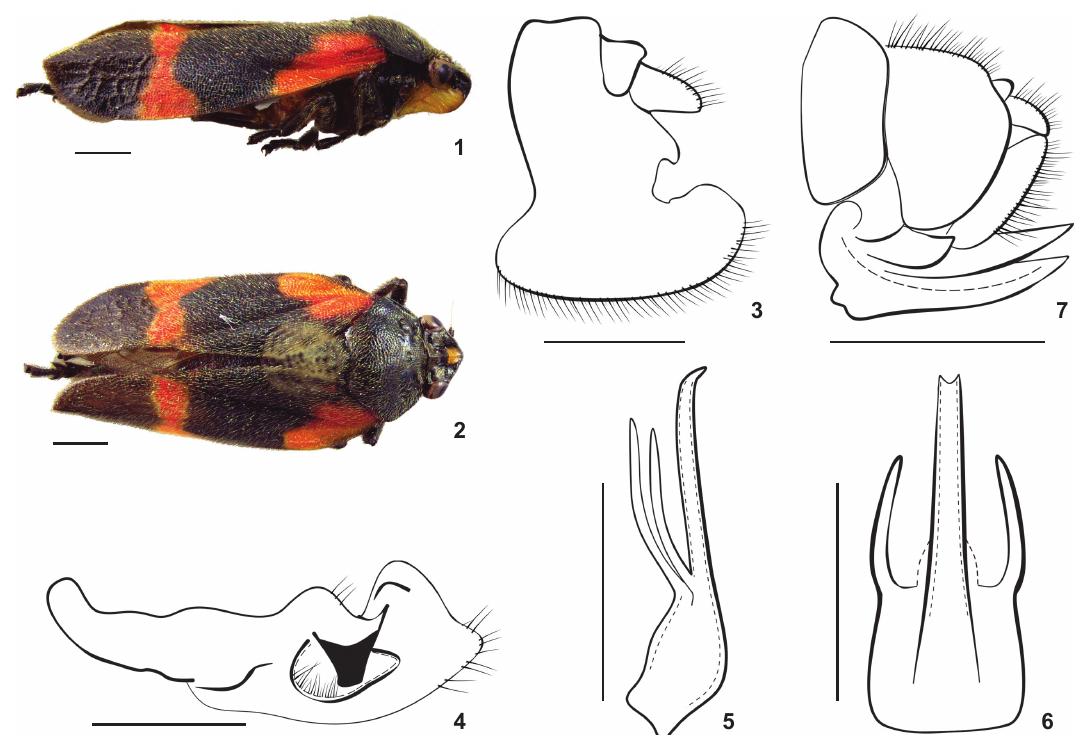
supra antennal margin carinate in dorsal view; antenna black, pedicel sparsely setose, basal body of the flagellum ovoid, arista slightly shorter than pedicel; apical third of postclypeus black and basal one orange, postclypeus inflated, convex in profile, with one median carina, lateral grooves strongly marked; ros- trum black reaching mesocoxae. Prothorax and mesothorax black, metathorax reddish; pronotum without median carina, pilose and strongly punctured, anterior margin straight, lateral- anterior margins straight, converging anteriorly and strongly carinate, lateral posterior margin slightly sinuous, posterior margin grooved; scutellum with slight central concavity, with slightly marked horizontal grooves on apical third; tegmina black with basal area reddish and reddish transversal stripe located between median and apical third before apical reticulation; ve- nation distinct with apical reticulation developed; hind wings translucid with brown venation, vein Cu not thickened at the 1 base; legs black, metathoracic tibia with two lateral spines, the basal smaller and the apical one and larger than those located in the apical crown of the tibia; basitarsus with one row of apical spines covered with a large amount of setae, subungueal spine present, small and